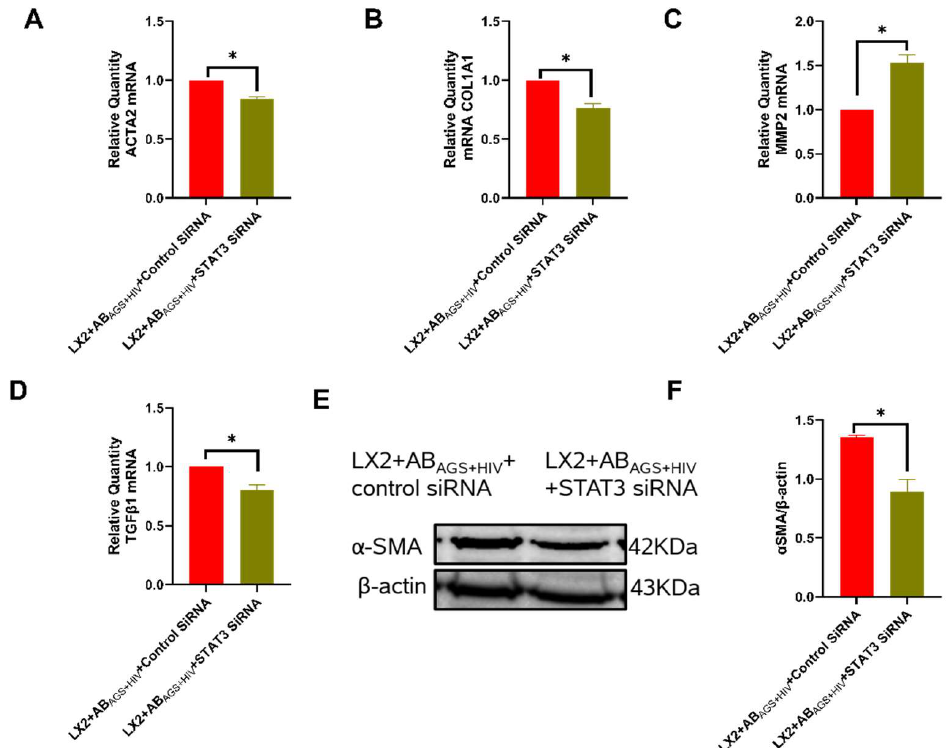
Figure 10. STAT3-deficient LX2 cells show downregulation of profibrotic genes and α -SMA after exposure to AB AGS+HIV : RT-PCR analysis of: ( A ) ACTA2 mRNA, ( B ) COL1A1 mRNA, ( C ) MMP2 mRNA, and ( D ) TGF β 1 mRNA. ( E , F ) α -SMA was measured by immunoblot analysis and the quan- tification of immunoreactive protein bands. Equal amounts of protein (20 µ g) were loaded in each lane. β -actin was used as an internal control. Data are from 3 independent experiments presented as mean ± SEM. Bars with * are significantly different from each other ( p ≤ 0.05).